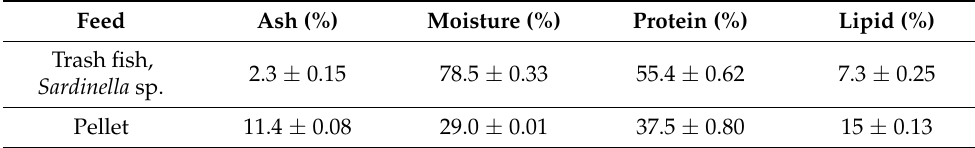
Table 1. Nutrient analysis (mean ± SE) of experimental feeds used. Feed Ash (%) Moisture (%) Protein (%) Lipid (%) Trash fish, Sardinella